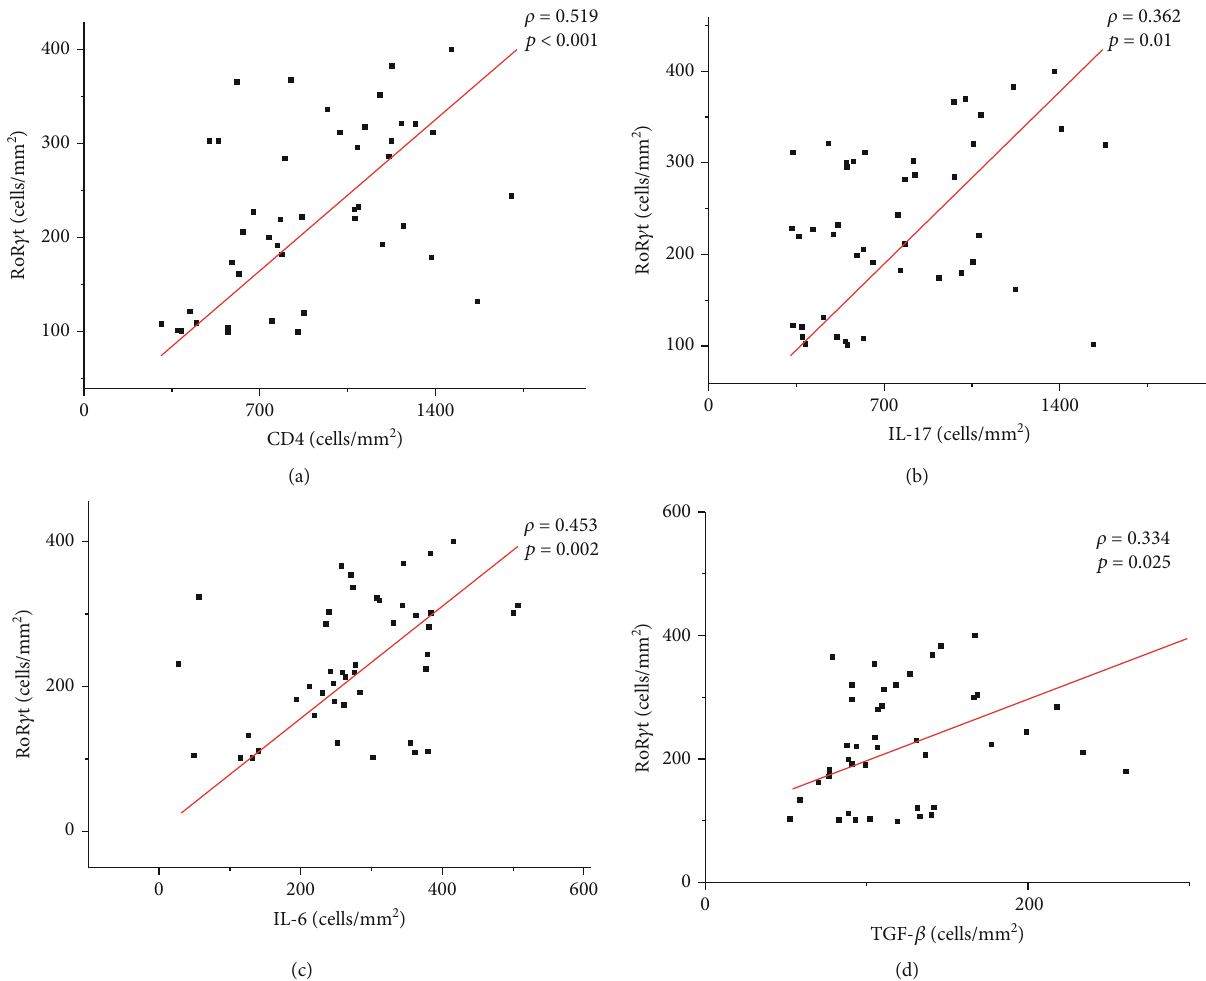
Figure 2: Graphs showing the correlation between the cellular density of RoR γ t + cells and CD4 + cells (a), IL-17 + cells (b), IL-6 + cells (c), and TGF- β + cells (d). The value of ρ is Spearman ’ s correlation coe ffi cient, and p is the p value. The red line indicates a positive correlation. 𝜌 = 0.409 p = 0.006